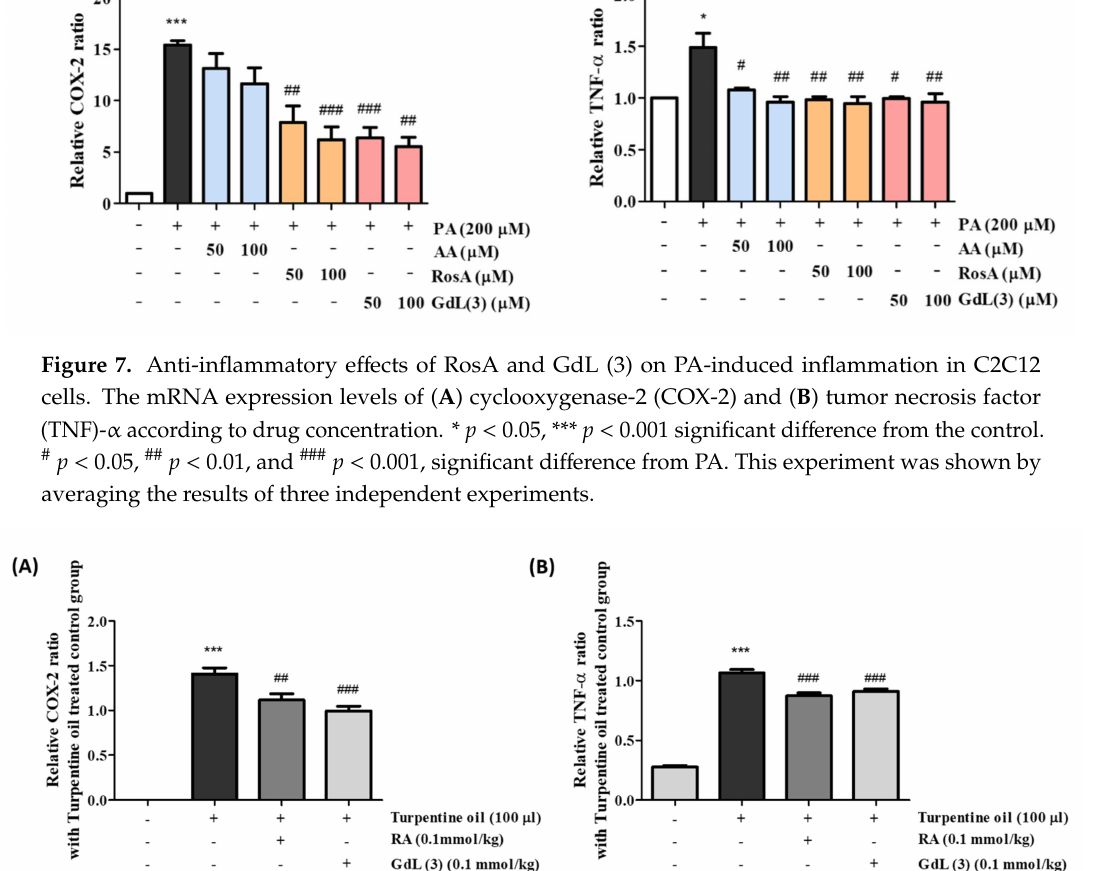
Figure 8. Anti-inflammatory e ff ects of RosA and GdL (3) on turpentine oil-induced inflammation (ICR mice). The mRNA expression levels of ( A ) COX-2 and ( B ) TNF- α according to drug concentration. *** p < 0.05, significant di ff erence from the control. ## p < 0.01 and ### p < 0.001, significant di ff erence from PA (n = 3–6 per